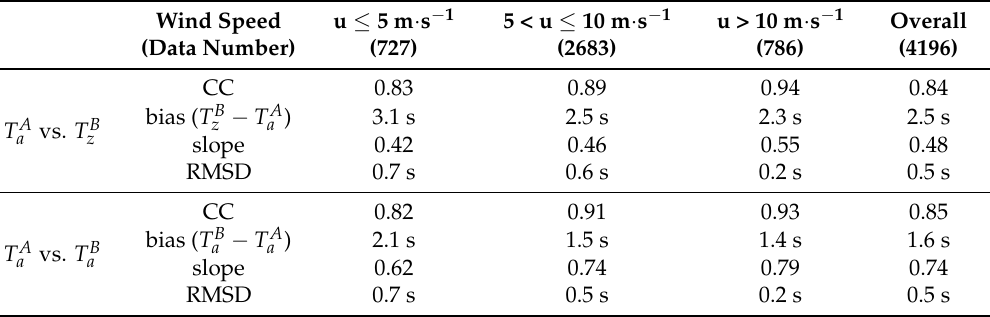
Table 1. Correlation coefficient (CC), bias, slope of the regression line, and root mean square difference (RMSD) around the regression line for T A a vs. T B z and T A a vs. T B a for various ranges of wind speed. All CC are significant at the 99.9% confidence level.